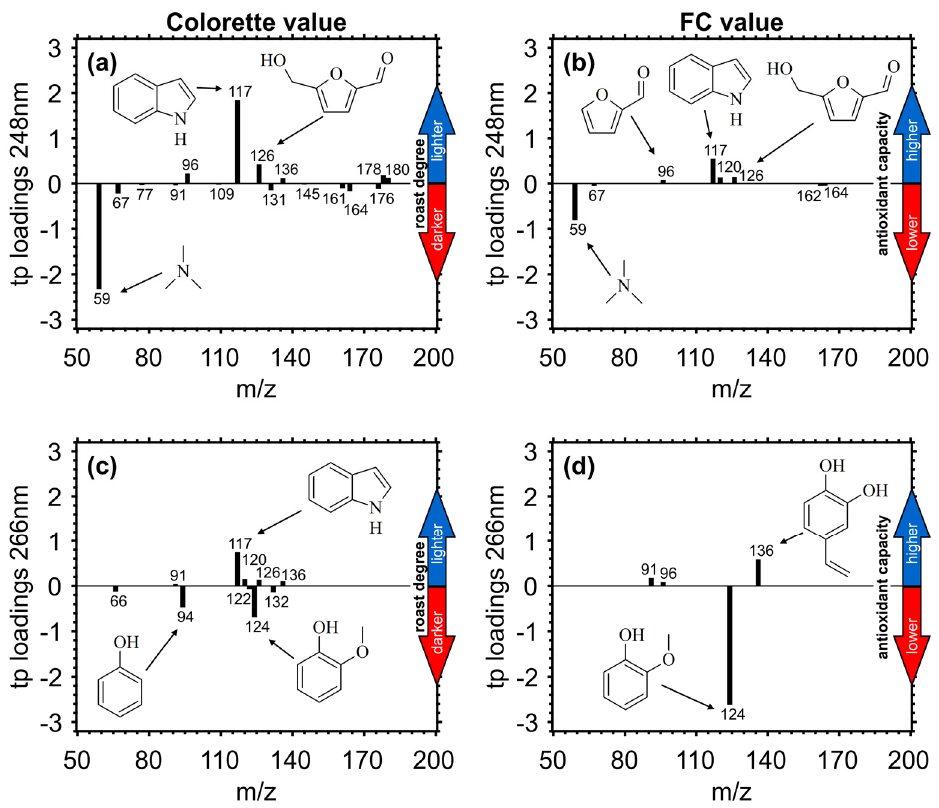
Figure 6. Target projection (TP) loadings as a metric of variable importance for prediction based on explained covariance for Colorette and FC values for REMPI measurements at 248 nm (upper panels ( a ) and ( b )) and 266 nm (lower panels ( c ) and ( d )). Positive TP loadings are more associated with higher Colorette and FC values, whereas negative TP loadings are more associated with lower Colorette and FC values. Structure assignments to m/z of TP loadings can be found in Table A1.